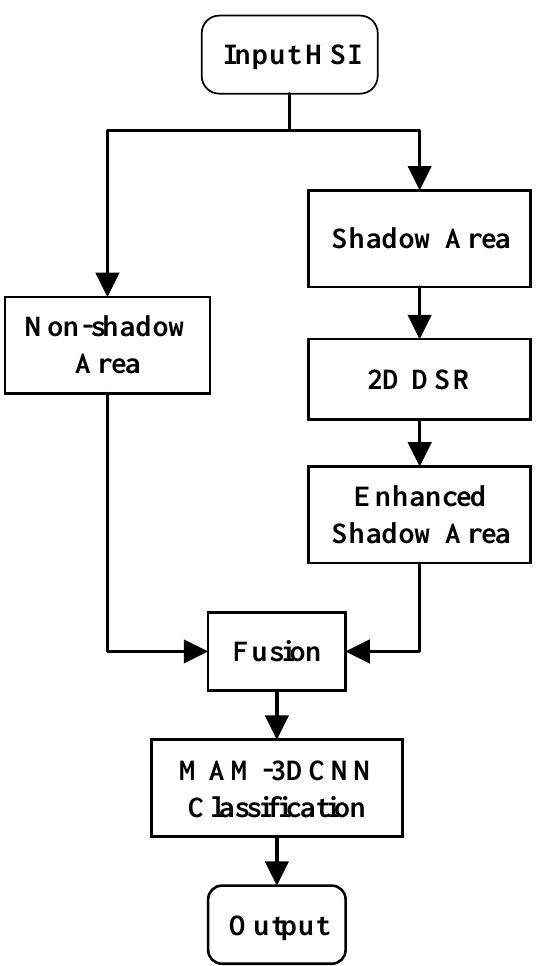
Figure 3. The main procedure of the proposed